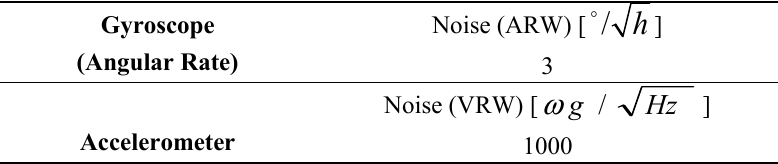
Table 1. Typical characteristics of a low-cost MEMS IMU.